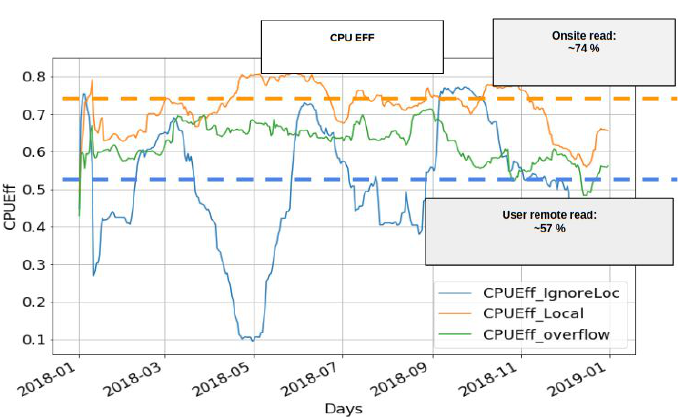
Fig. 2. Distribution of CPU efficiency over 2018. Yellow is the CPU eff. of jobs reading data from the local storage. Blue color relates to jobs reading data from remote storage (no Cache is